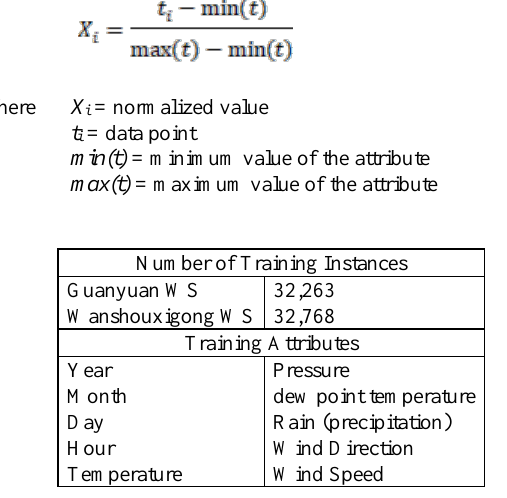
Table 2. Properties of training data Training was performed for each concentration separately using the 80% of instances for each weather station. The rest of the data (20%) were used in the testing phase. R 2 (coefficient of determination) and the mean-squared error (MSE) metrics were used to evaluate the prediction ability of the considered algorithms. R 2 score is a statistical measure of the predicted and observed points to determine how well the regression line fits data. A higher value (maximum=1) indicates the better-fitted data. Equation 2 shows the formula of the coefficient of determination (R 2